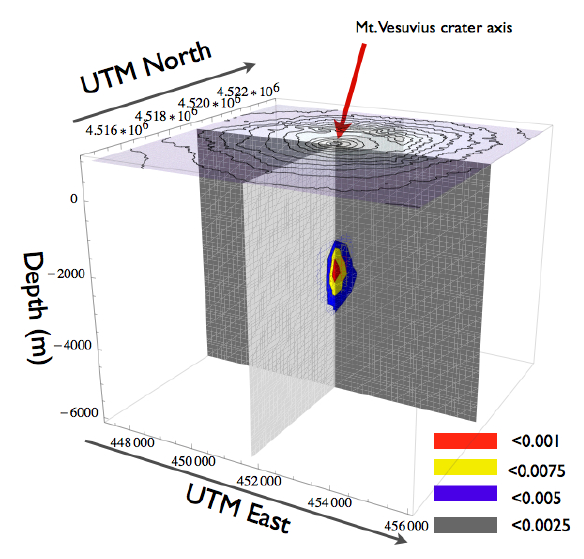
Figure 2. 3-D plot of the location probability (Equation 1) for earth- quakes with magnitude between 2.5 and 3.6 occurred between 1987 and today. Color scale represents the quantity P [ x , y , z , 2.5, 3.6]. Relevant energy emission corresponds to the red zone, which is strictly confined in a very narrow (500 m) and thin (1000 m) volume centered at −2500 m below the sea